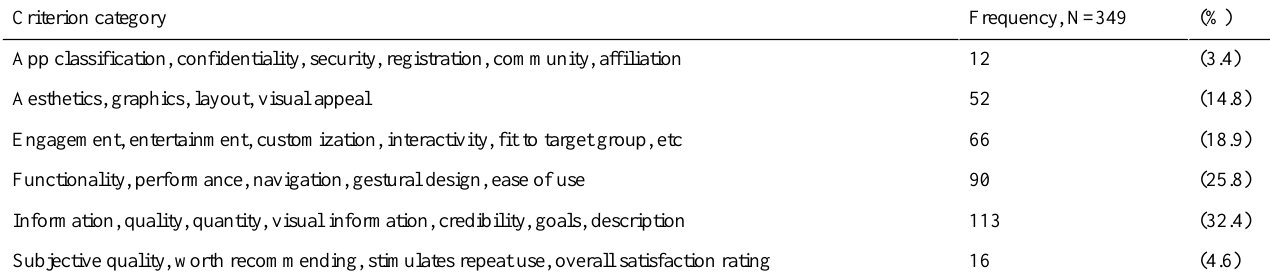
Table 1. Number of criteria for evaluation of mHealth app quality identified in the literature